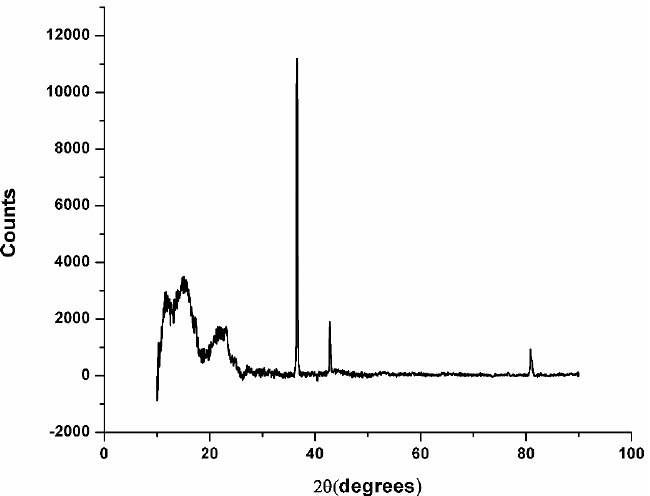
Figure 4. XRD analyses for Fiber Wood material.